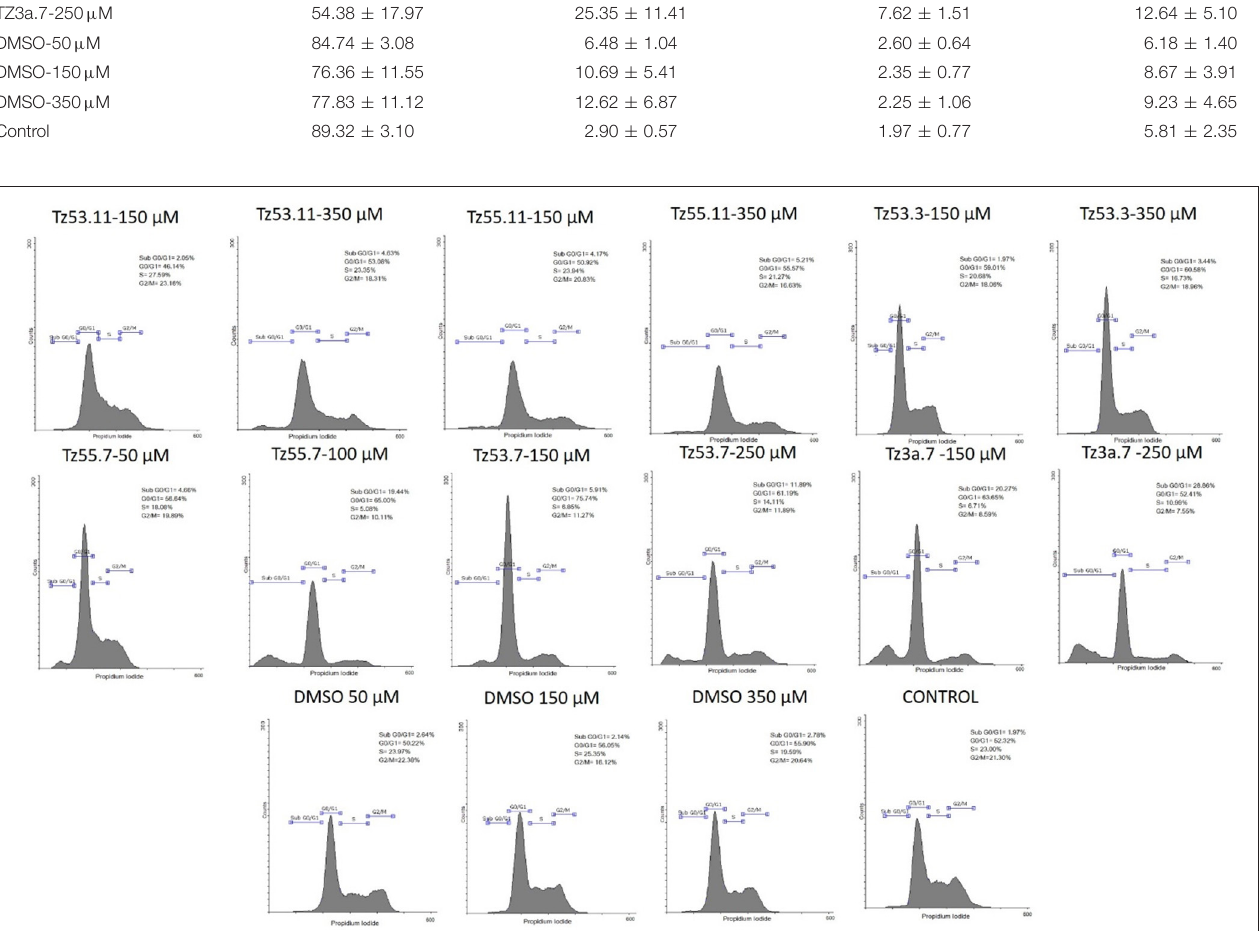
FIGURE 10 | Representative histograms for the flow cytometric analysis of HT-29 cell cycle stimulated with test compounds.